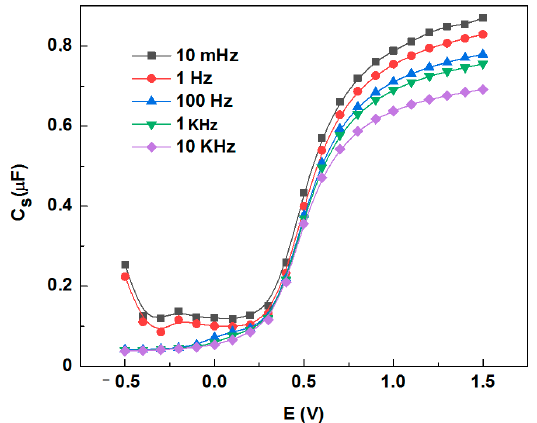
Figure 3. Typical C(V) response to frequency changes from 100 mHz to 100 kHz.